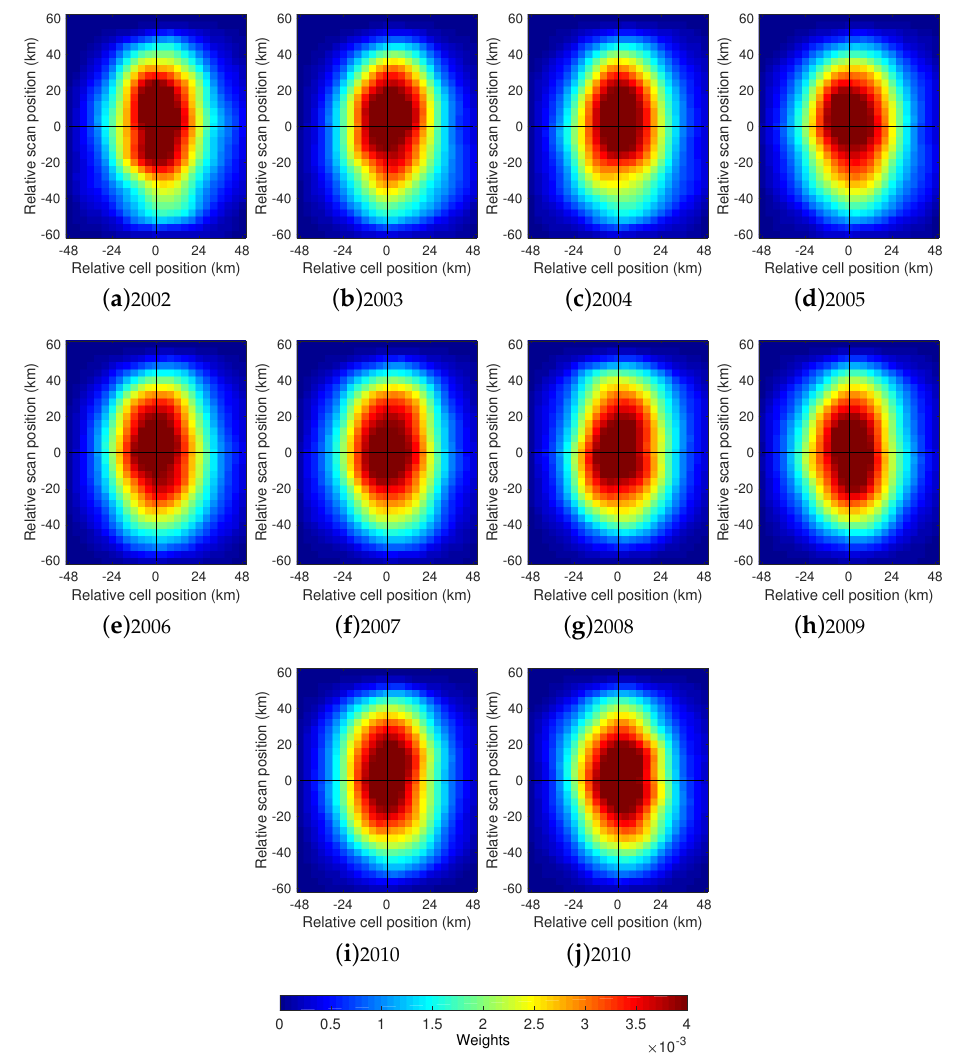
Figure 12. Year-by-year estimates of the across-track average footprints.